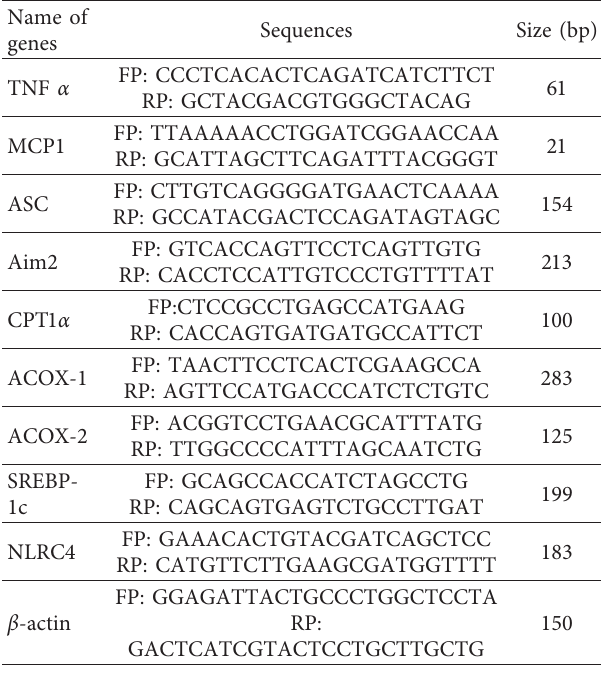
Table 1: Primer sequences (human).